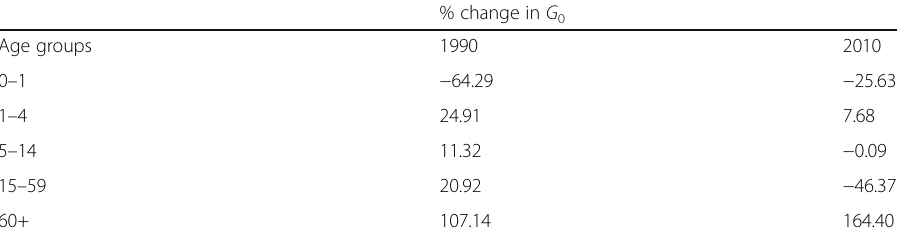
Table 5 Age-specific contributions to the difference in Gini coefficient between men and women, India, 1990 and 2010